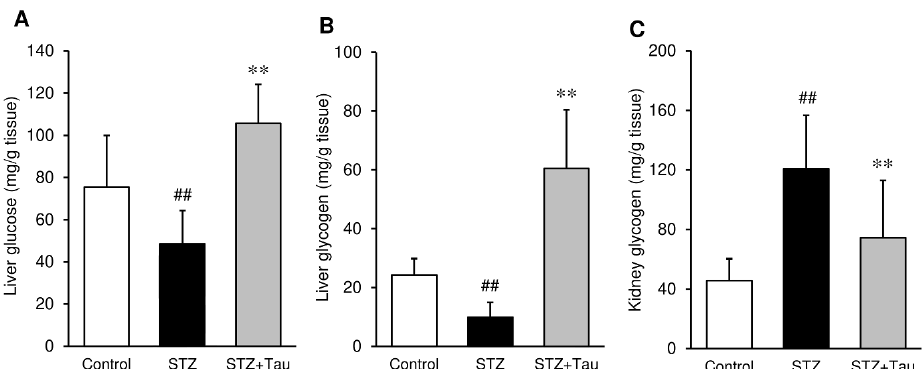
Figure 3. Effects of taurine supplementation on the glucose and glycogen content in the liver and kidney in diabetic mice. ( A ) Liver glucose, ( B ) Liver glycogen, ( C ) Kidney glycogen. Glucose and glycogen levels were measured using commercially available kits. Each value is expressed as the mean ± S.D. ( n = 7–8). ## p < 0.01 vs Control group, ** p < 0.01 vs. STZ group.